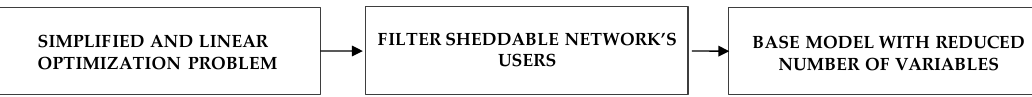
Figure 4. Basic flowchart of the Decomposition Model.